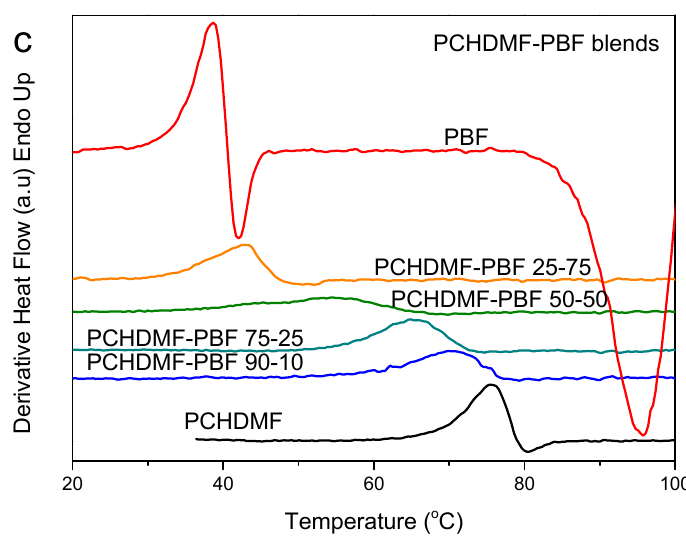
Figure 9. ( a ) DSC heating thermograms, ( b ) details of DSC thermograms in the T g region and ( c ) derivative heat flow for melt-quenched PEN–PEF blend samples.